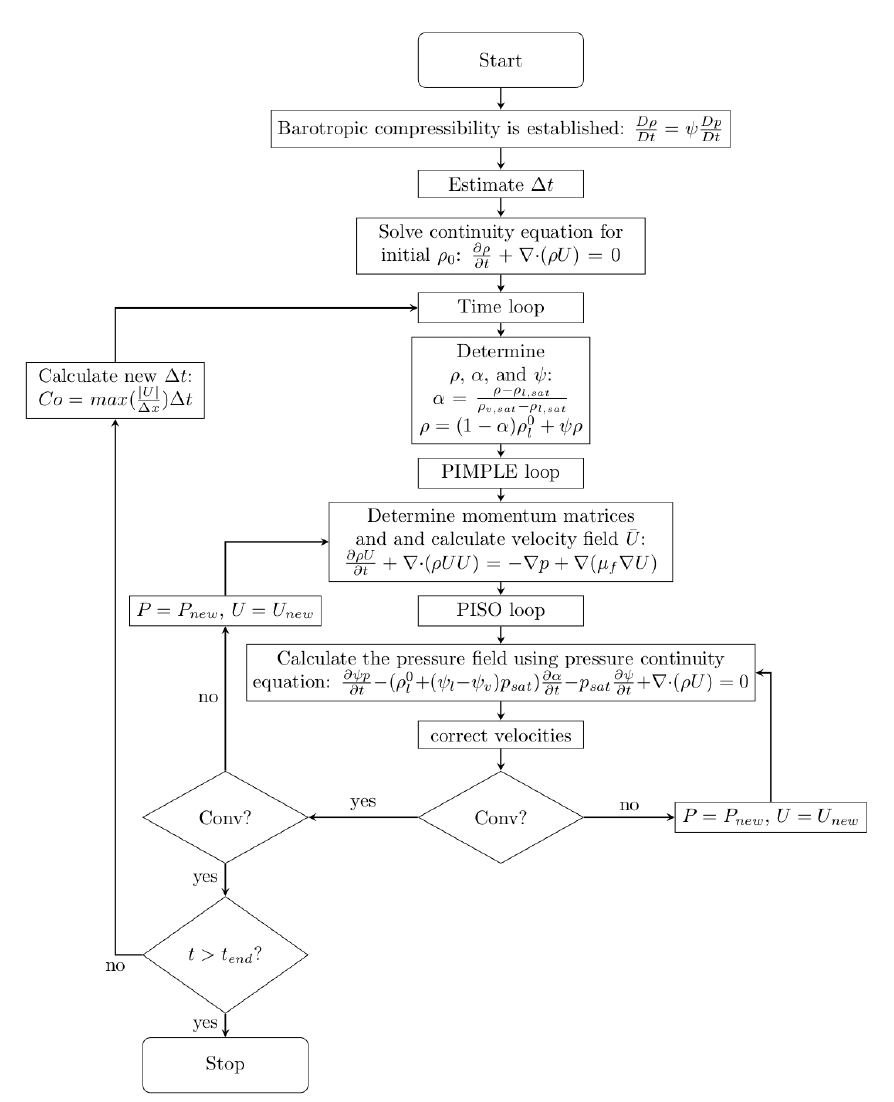
Figure A1. Flow chart of the PIMPLE solution